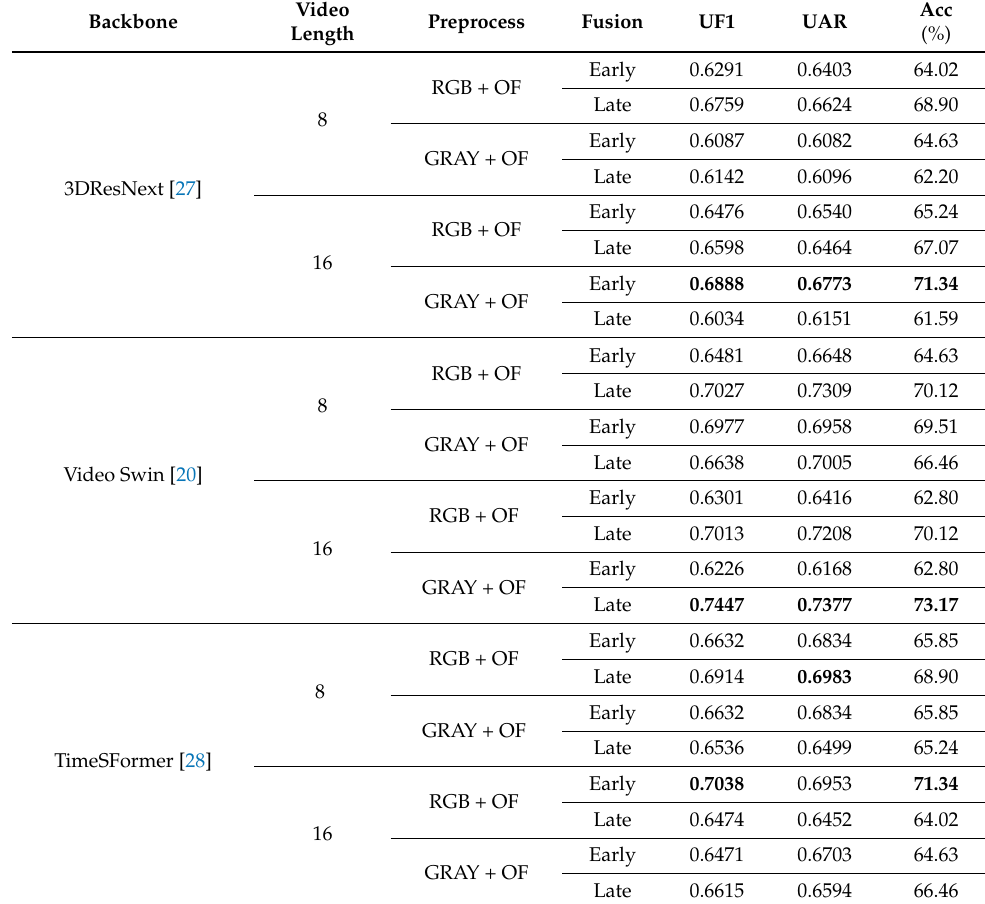
Table 6. Comparison of early vs. late